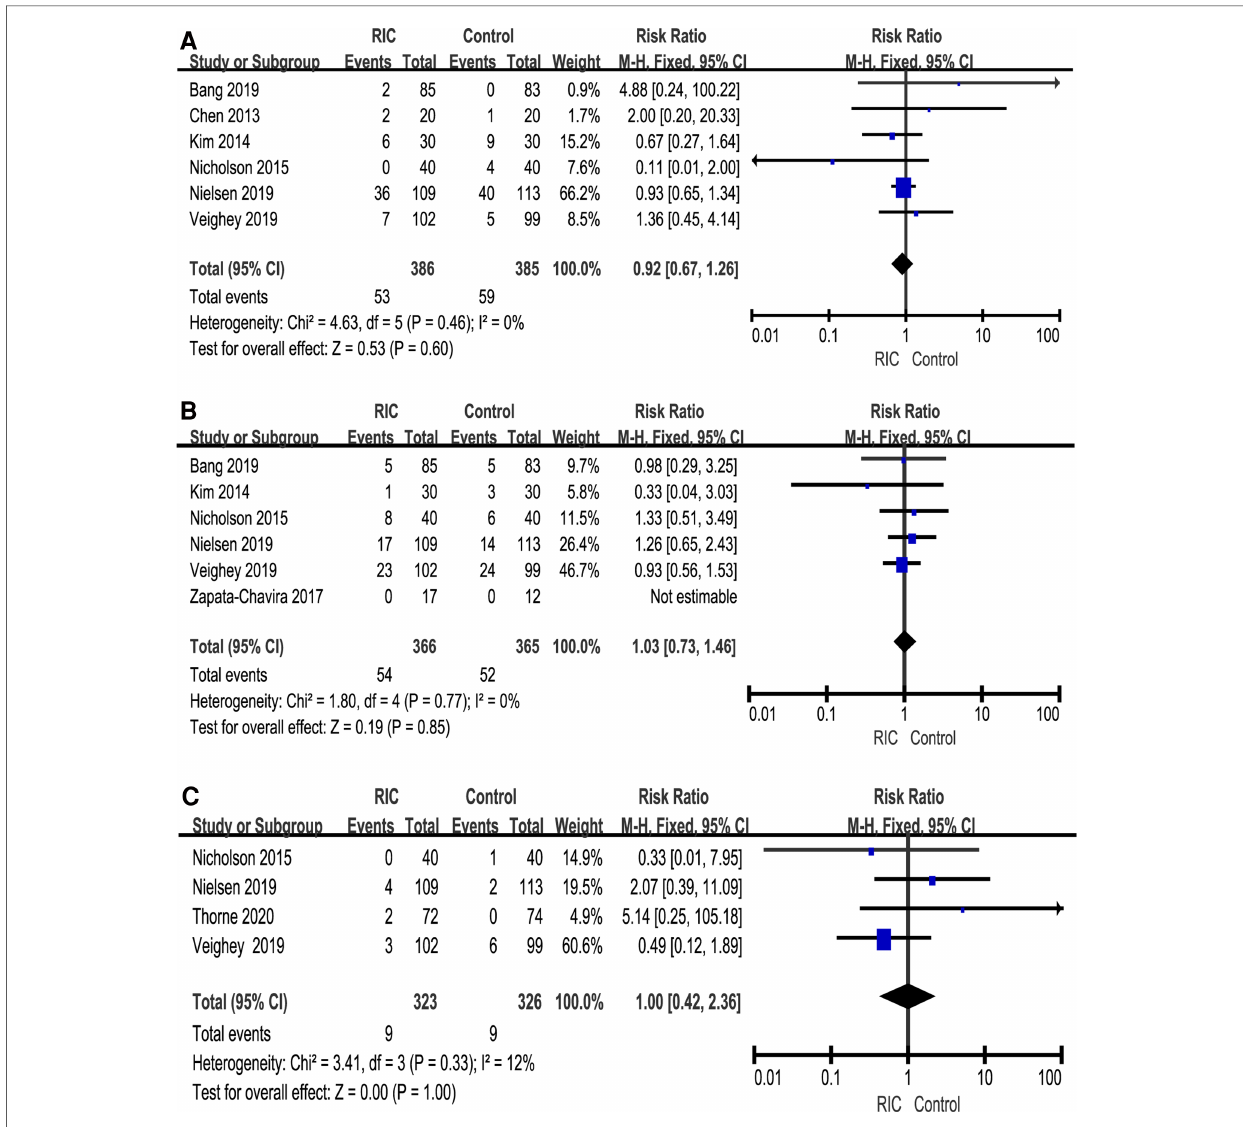
FIGURE 6 Forest plot with 95% con fi dence intervals for the rates of DGF ( A ), AR ( B ) and graft loss ( C ). RIC, remote ischemic conditioning; DGF, delayed graft function; AR, acute